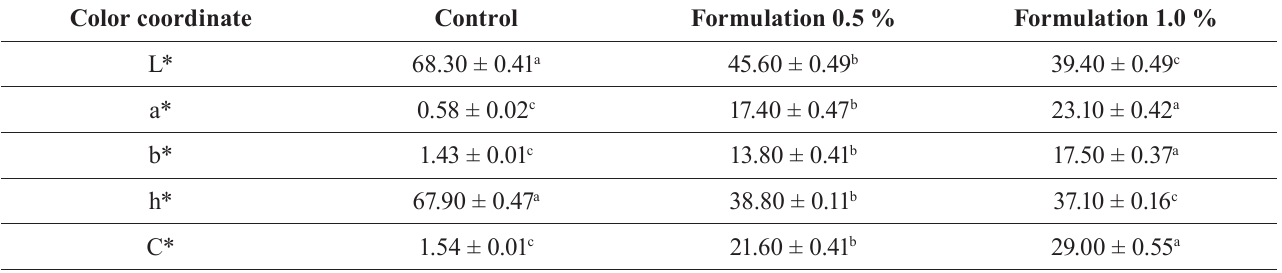
TABLE IV - Mean values of the color coordinates of the developed beverages with 0.5% and 1.0 % of bacaba peel extract